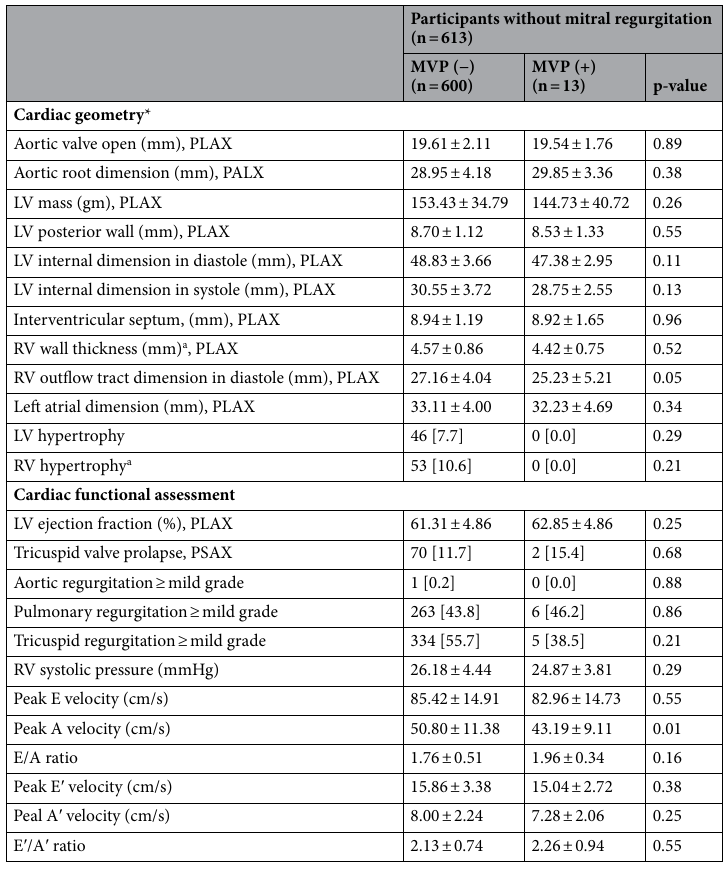
Table 3. Comaprisons of cardiac structure between participants with mitral valve prolapse and those without in absence of mitral regurgitation. Continuous variables are expressed as mean ± SD (standard deviation), and categorical variables as N [%]. BSA body surface area, LV left ventricle, RV right ventricle, PLAX echocardiographic parasternal long axis view, PSAX echocardiographic parasternal short axis view a N = 512. *indicates the p-value for the echocardiographic geometry variables with adjustment for body surface